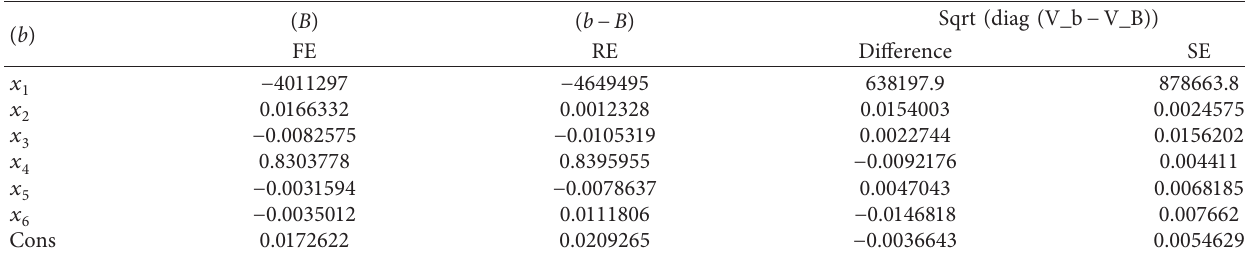
Table 4: The findings of Hausman test.